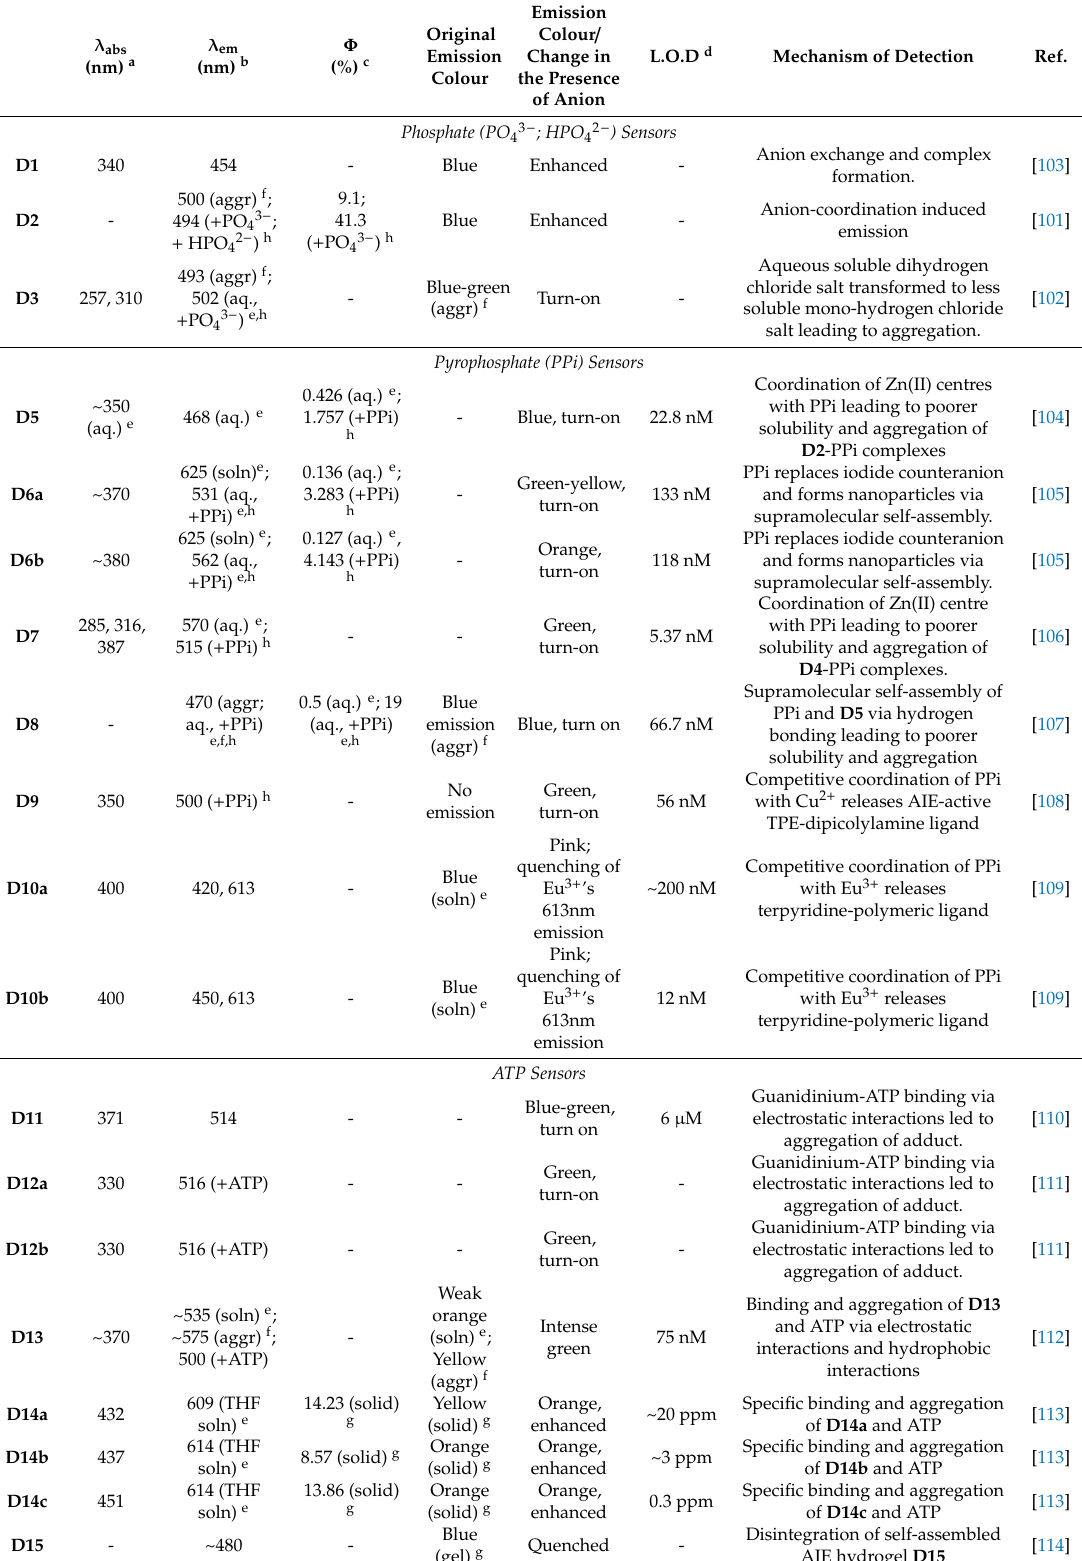
Table 7. Summary of optical properties and sensing performance of AIE-based sensors for the sensing of phosphorous-containing anions ( D1 – D14 ).